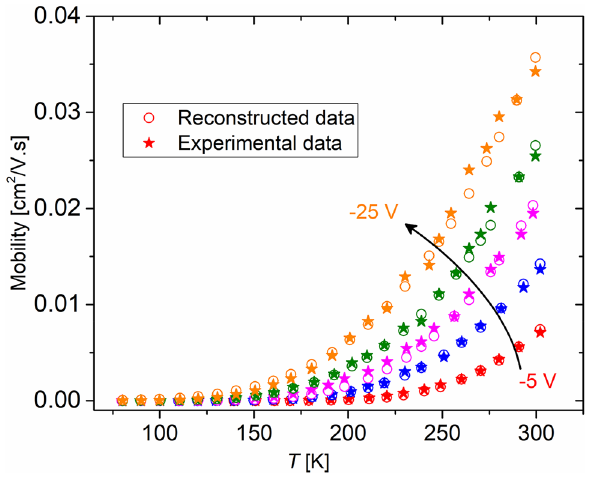
Figure 5. Comparison between the experimental data (blue symbols) and the reconstructed values from renormalization (red symbols) for pentacene OFET (data extracted from Ref. 19